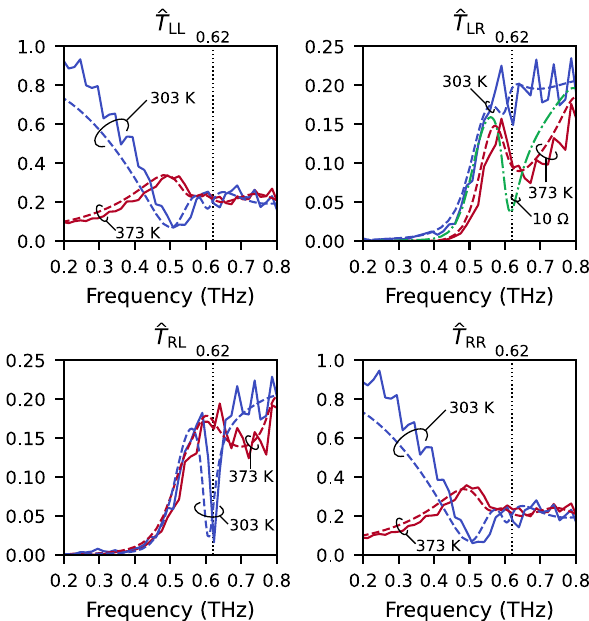
Figure 3: Normalized power transmission spectra of the metasurface for circularly polarized waves at 303 and 373 K. The solid and dashed curves show the experimental and numerically used to simulated results, respectively. The sheet impedances Z s film in the simulation are 1000 Ω for 303 K and 30 Ω model the VO 2 for 373 K, respectively. The green dashed-dotted line in ̂ T shows LR = 10 Ω . the simulated spectrum for Z s